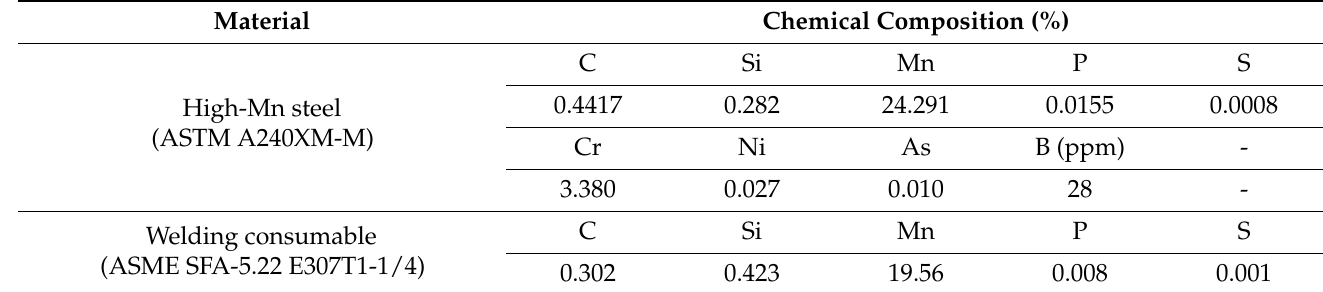
Table 3. Chemical compositions of high-Mn steel (base material) and the welding